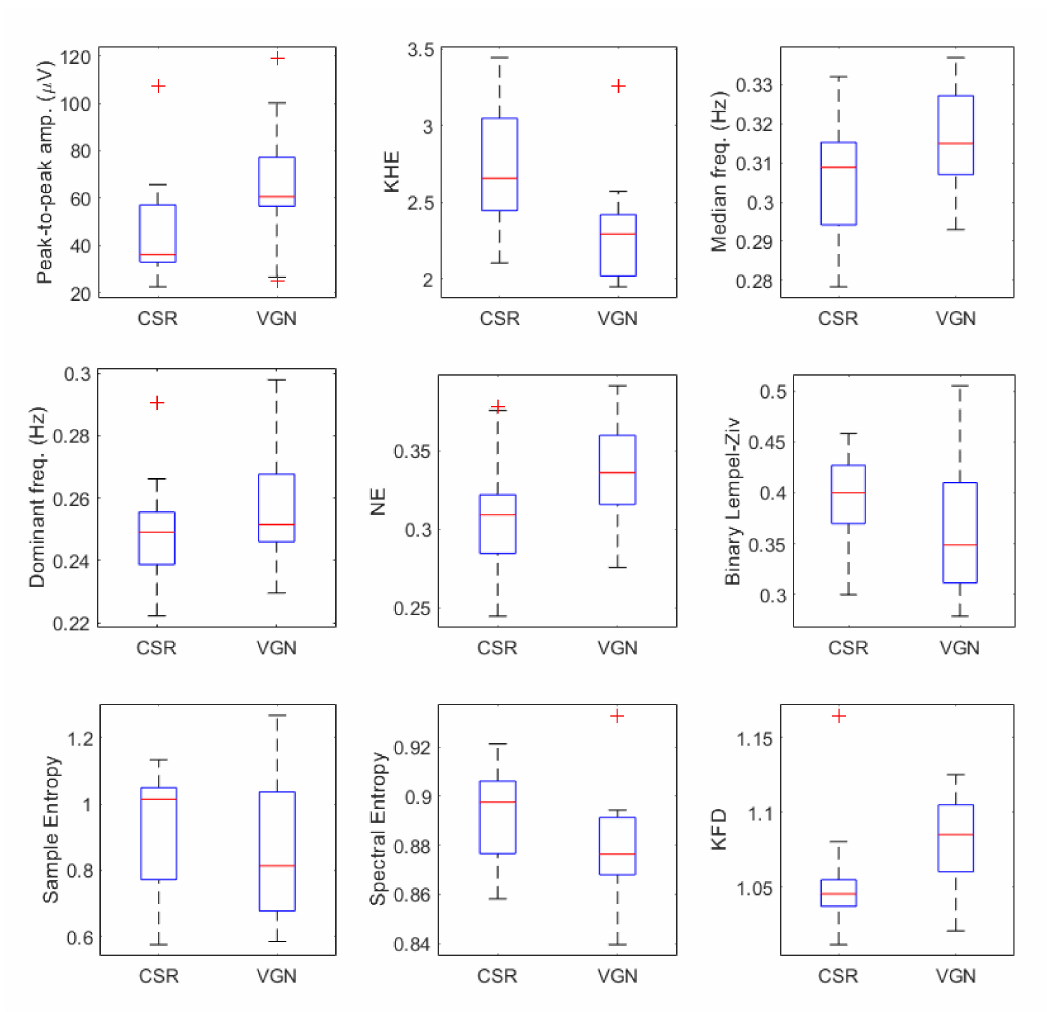
Figure 3. Distribution of postpartum EHG parameters for cesarean (CSR) and vaginal (VGN)